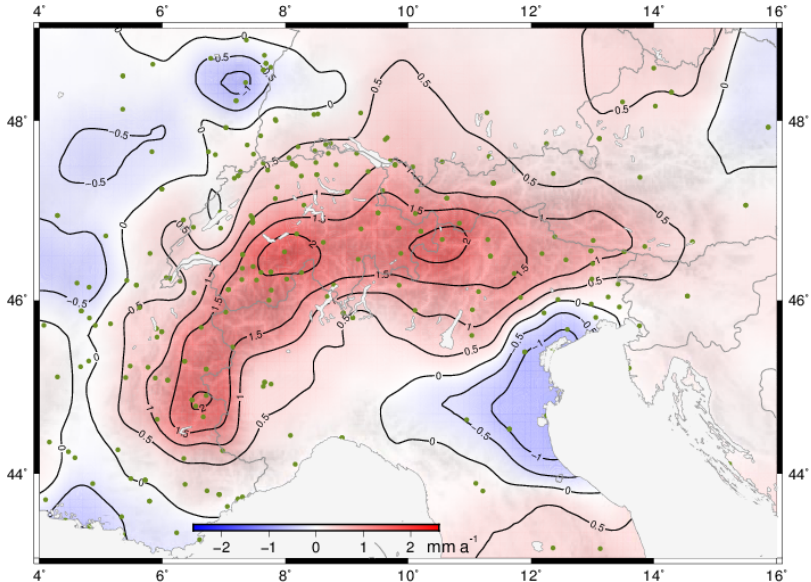
Figure 11. GNSS-inferred vertical deformation model of the Alpine region. Green dots show the CO-GNSS station distribution. Topography after the ETOPO1 model (Amante and Eakins, 2009).